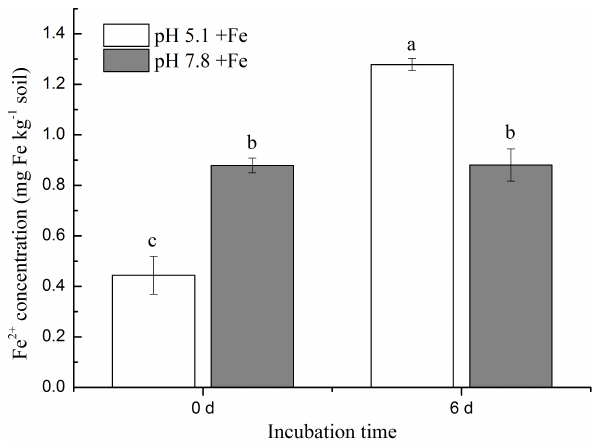
Figure 5. Effects of Fe oxide on concentration of Fe(II) (0.5molL − 1 HCl extractable) before and after 6 days with ( 15 NH 4 ) 2 SO 4 treatment incubation at 28 ◦ C with soil moisture at 100% WHC. Error bars represent standard deviations; n = 3. The different letters above the columns indicate a significant difference ( P